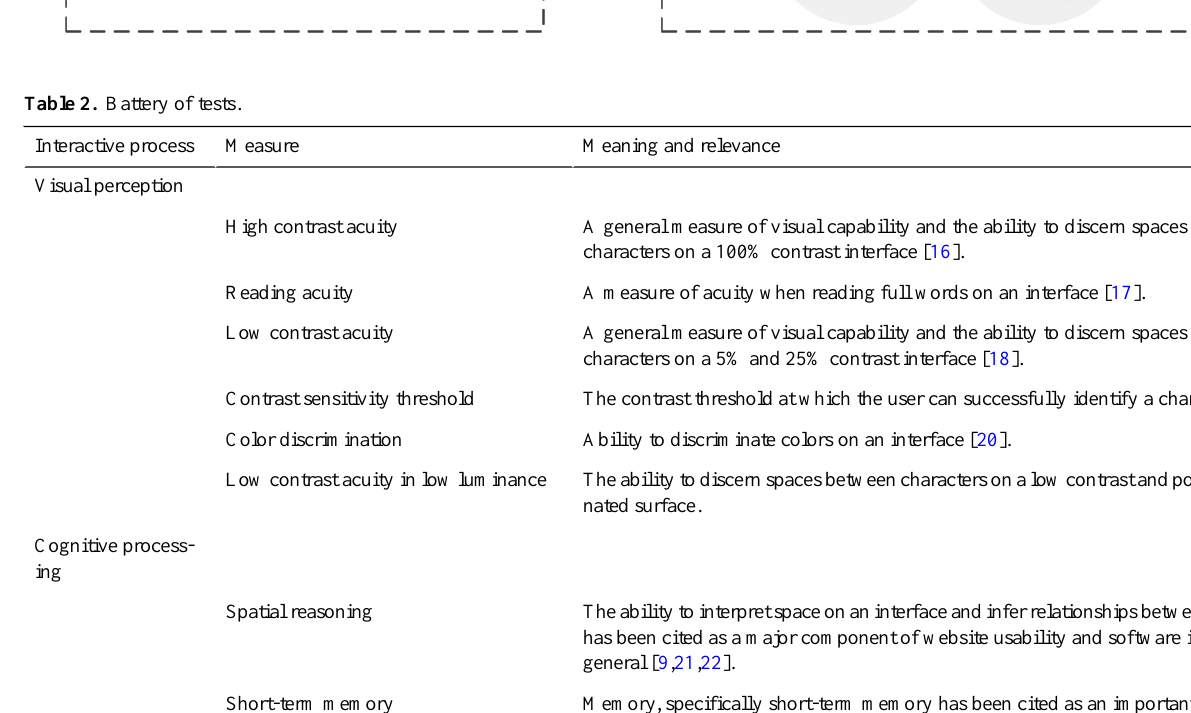
The ability to interpret space on an interface and infer relationships between elements has been cited as a major component of website usability and software interfaces in